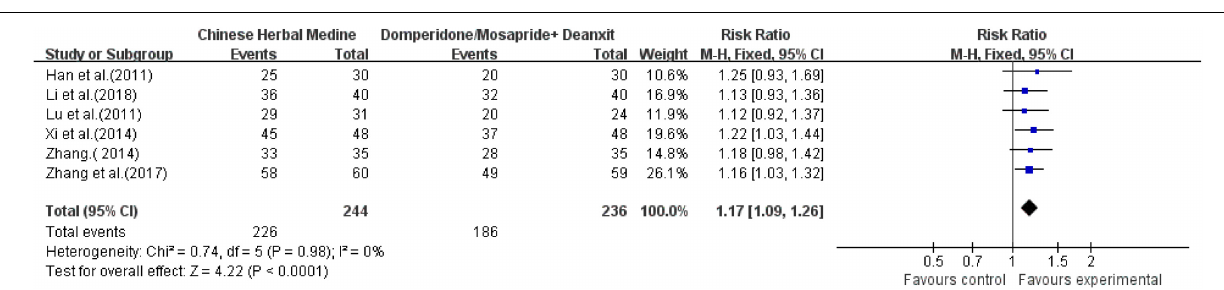
FIGURE 4 | Meta-analysis of total effective rate of CHM vs. placebo.